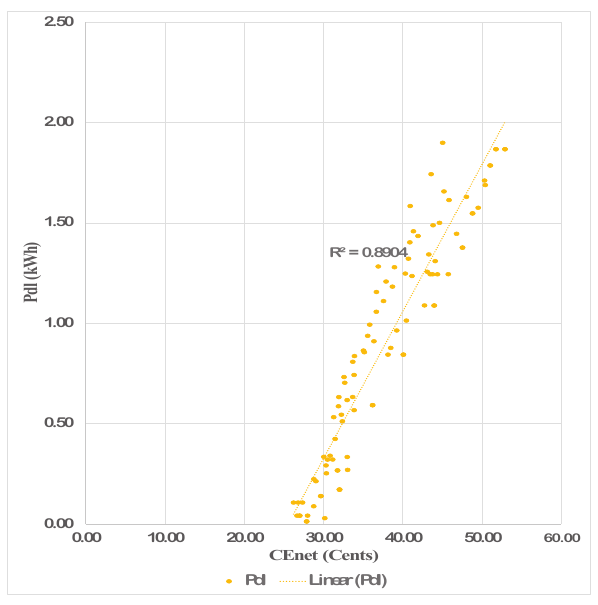
Figure 7. Relation between CEnet and Pdl for DRSREODLDG-based HEMS.